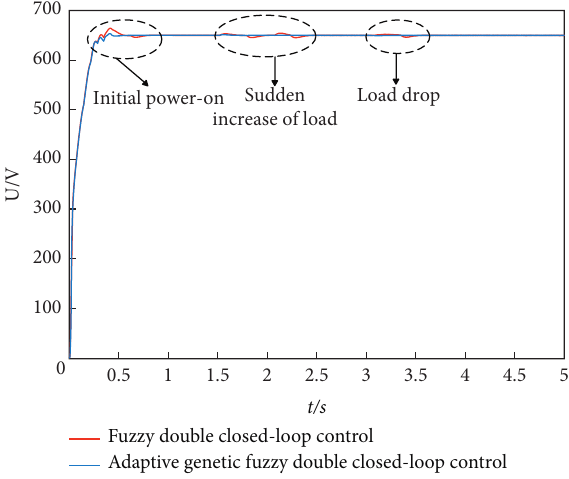
Figure 9: Microgrid 2 bus voltage Figures 11 and 13 are the bus voltage diagrams of microgrid 2 and microgrid 1 in fuzzy double closed loop and adaptive genetic fuzzy double closed loop, respectively.